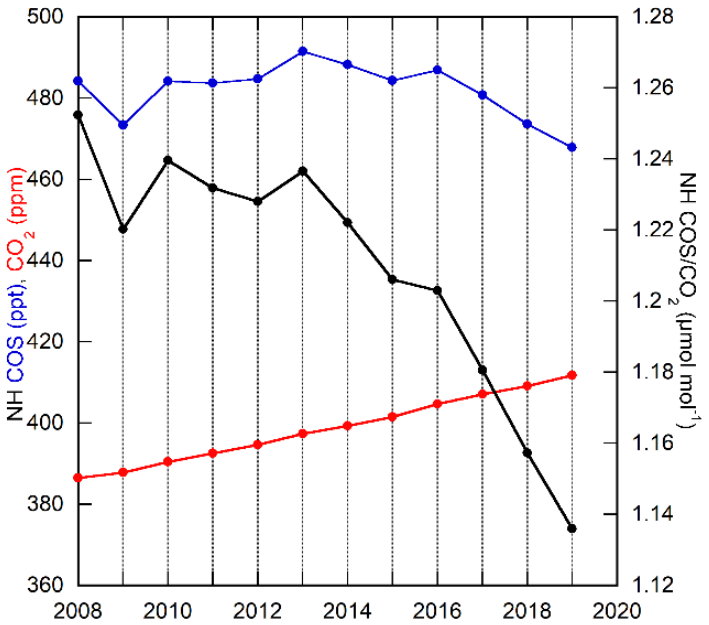
Figure 1. Time-evolving NH means of COS and CO2 mixing ratios and of the COS-to-CO2 ratio calculated from NOAA data (2008–2019) using the method of [17], following [7]. Hence, during the 2009–2013 period, the change in the NH COS-to-CO 2 ratio was very small (1.23 ± 0.01). An inflexion point was reached in 2013 (Figure 1). The trend in the